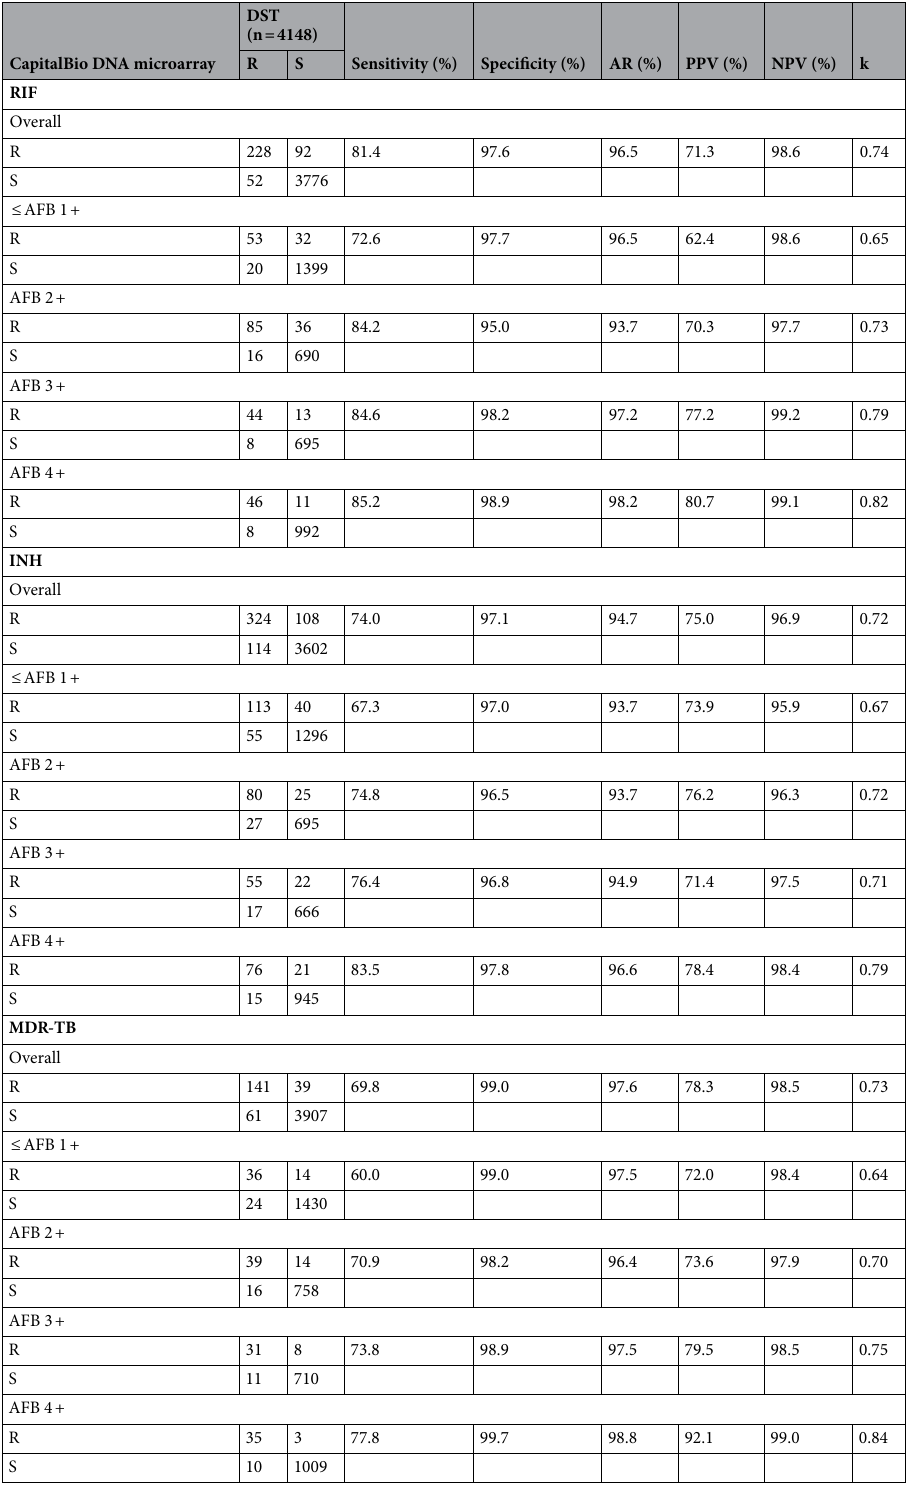
Table 1. The drug susceptibility test was used as a standard method to evaluate the efficacy of the DNA microarray for detecting RIF and INH resistance and MDR-TB. DST drug sensitivity test, R resistant, S susceptible, AR agreement rate, PPV positive predictive value, NPV negative predictive value, AFB acid-fast